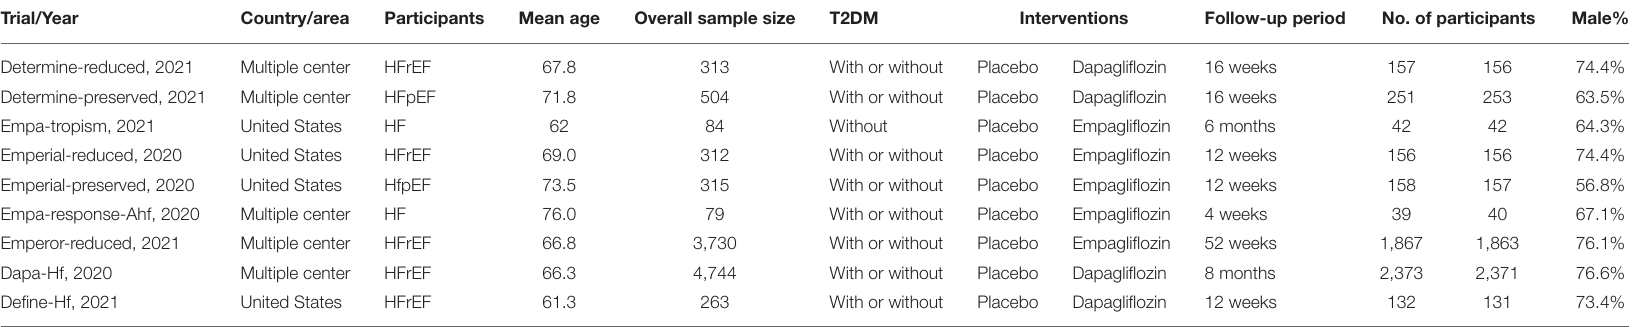
TABLE 1 | Main characteristics of the 10 randomized controlled trials in this